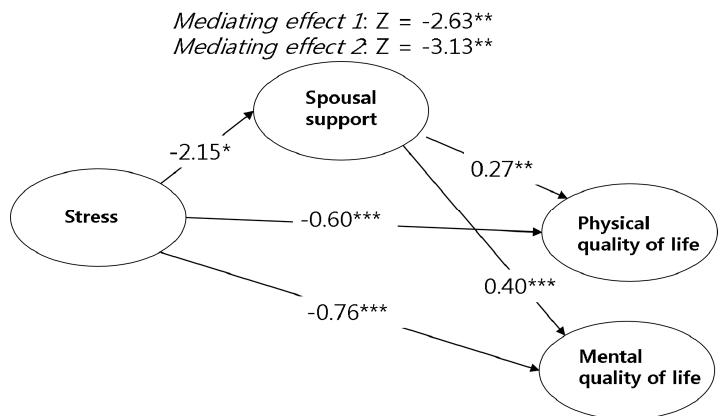
Figure 1. Mediating effects of spousal support in the relationship between stress and health-related quality of life ( β ); * p < 0.050; ** p < 0.010; *** p < 0.001.